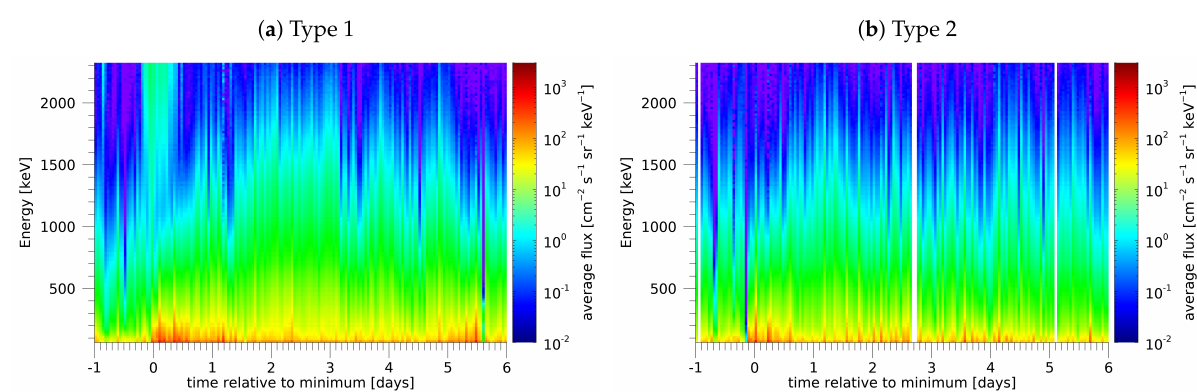
Figure 4. Average energetic particle fluxes in L-shell range between 1 and 6 as a function of energy (ordinate) and time relative to the Dst minimum (abscissa) for Type 1 storms ( a ) and Type 2 storms ( b